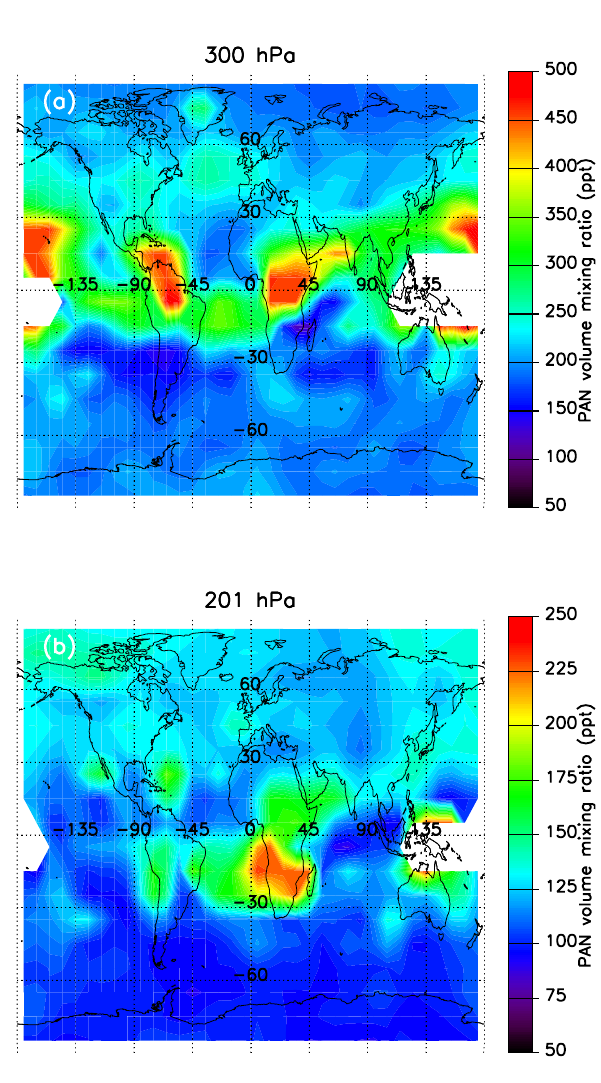
Fig. 6. Global PAN distributions (in units ofppt) at average pressure levels of 300hPa (a) and 201hPa (b) averaged for the month of January 2003. White areas are cloud contaminated